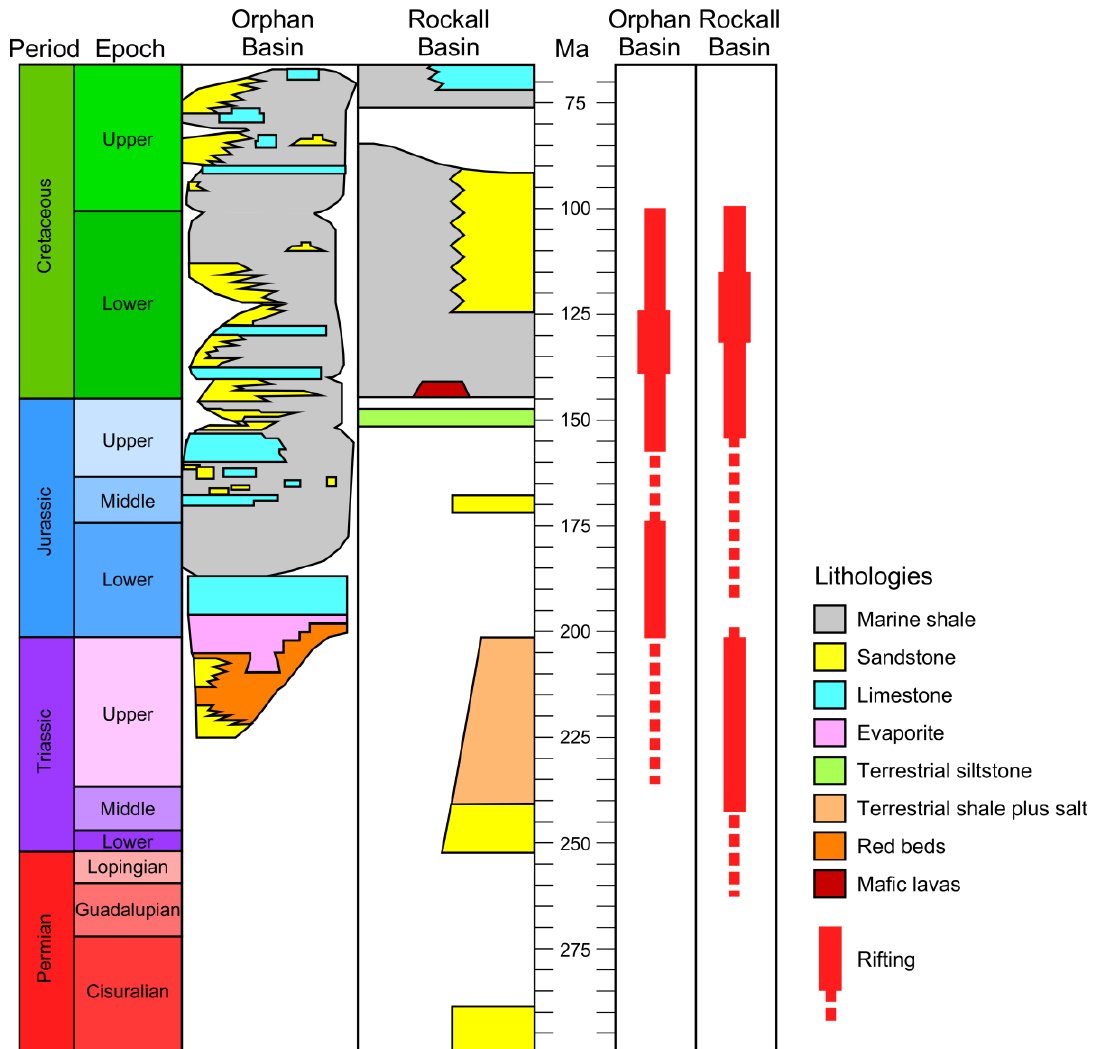
Figure 2. Simplified lithostratigraphic chart from the Permian to the Cretaceous for the Orphan Basin and the Rockall Basin. Orphan Basin chart adapted from [25] and Rockall Basin chart adapted from [39]. Timescale based on [40].